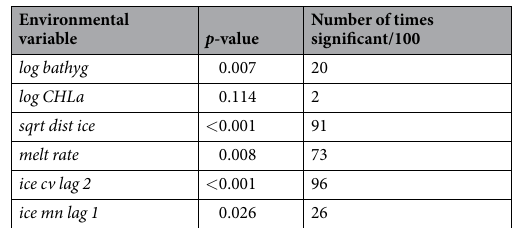
Table 4. Significance of environmental predictors influencing whale behaviour. P -values indicate approximate significance of GAMM smooth terms based on Chi-sq. statistics. Second column indicates the number of times each environmental variable 105–109 was determined to be significant (based on p -value < 0.05) under the resampling procedure (n = 100 iterations, resampling randomly from the state-space model posterior estimates for behavioural state and